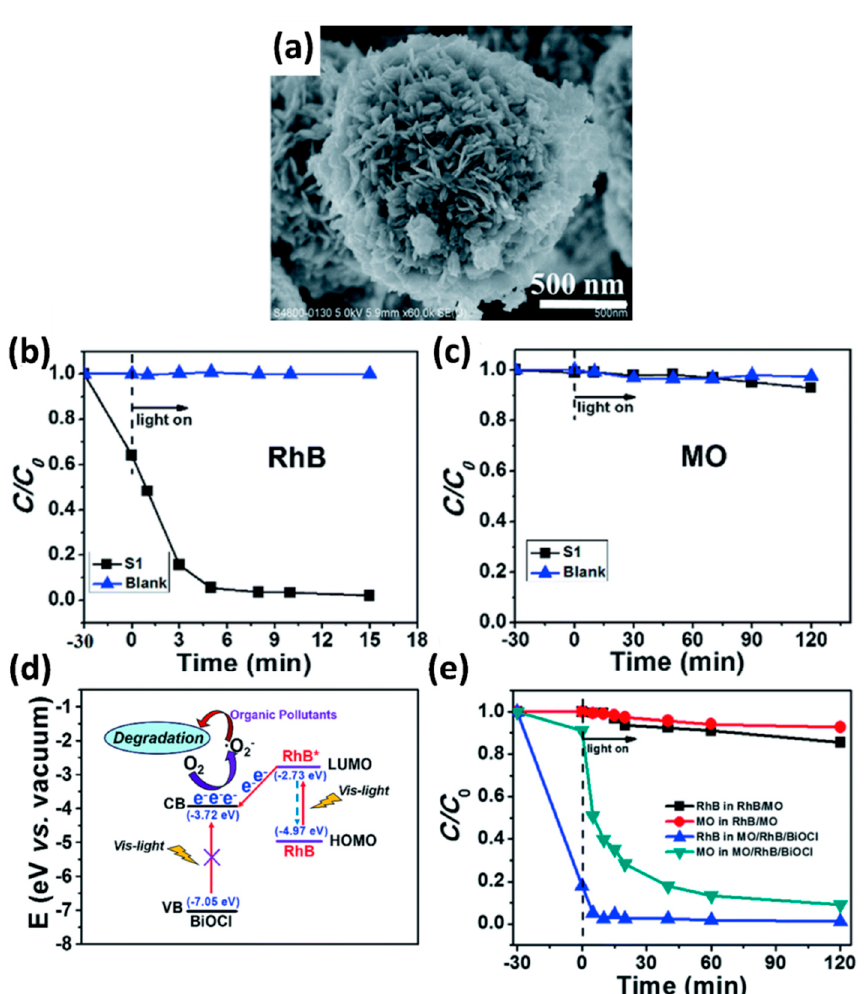
Figure 17. ( a ) SEM image of BiOCl and the results of ( b ) RhB and ( c ) MO photodegradation under visible irradiation. ( d ) Proposed mechanism for the enhanced MO photodegradation on RhB/BiOCl under visible irradiation. ( e ) Photodegradation of RhB and MO on RhB/BiOCl (reproduced with permission from [63] . Copyright Royal Society of Chemistry, 2016.).